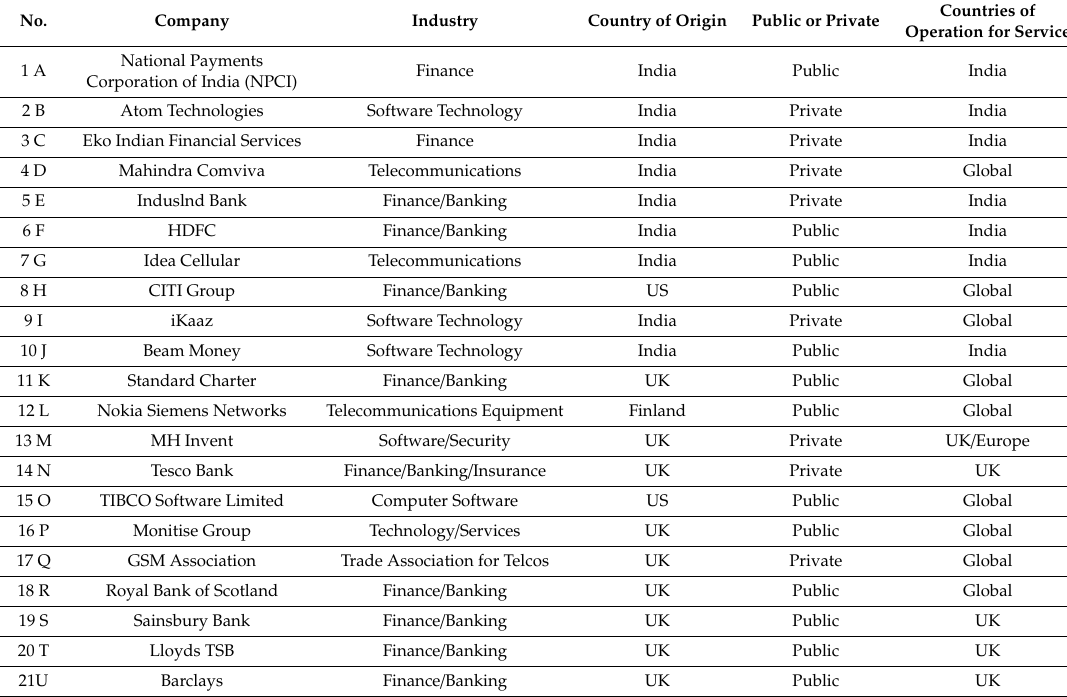
Table A1. Interviews and surveyed